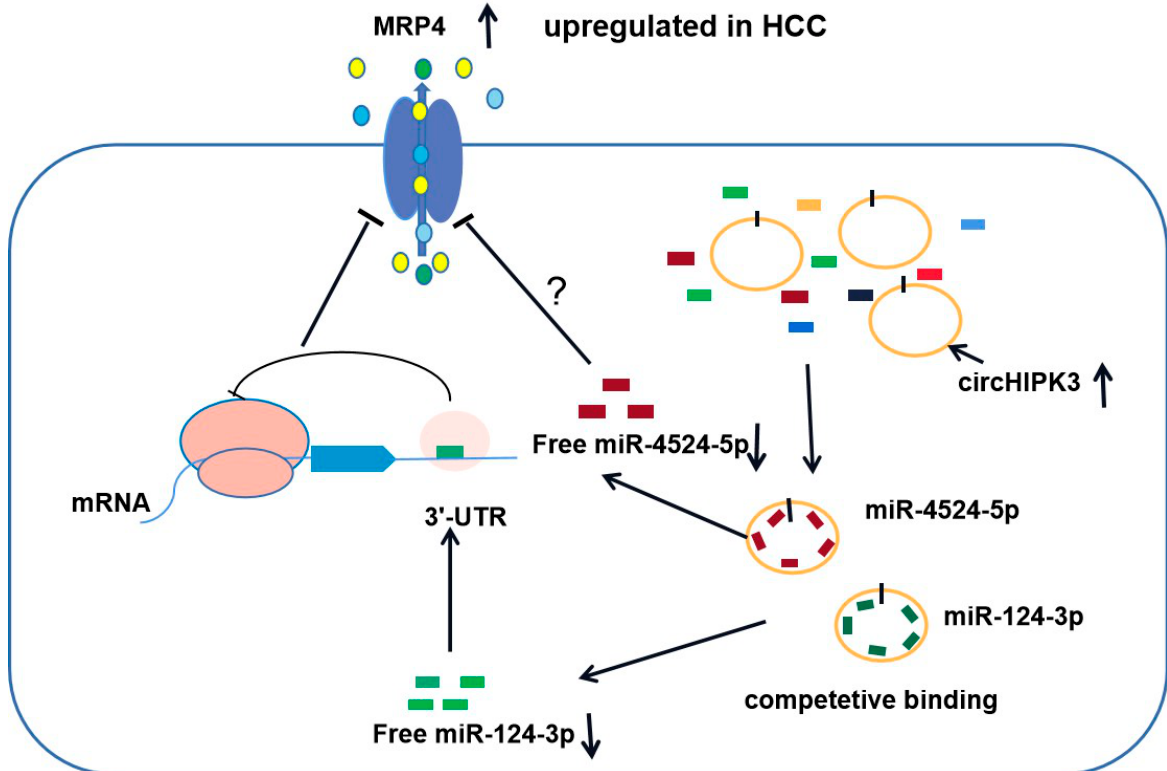
Figure 5. The proposed molecular mechanism of how circRNA regulates the expression of MRP4. MRP4 is upregulated in HCC. miR-124-3p and miR-4524-5p reduced the expression of MRP4 at the protein but not mRNA level. circHIPK3, as a competitive endogenous RNA, binds with miR-124-3p and miR-4524-5p to decrease free miRNAs, which leads to MRP4 upregulation in HCC.